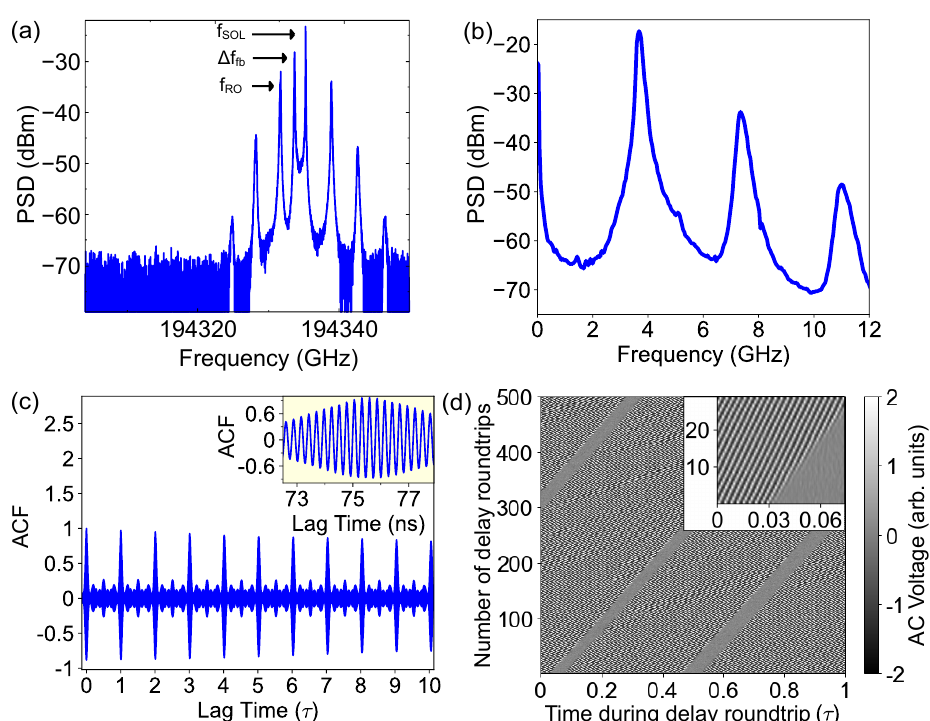
Figure 7. Characteristics for undamped relaxation oscillation dynamics at a bias current of I = 18 mA and a feedback rate that has been attenuated by 31 dB from its maximum value. ( a ) Optical spectrum, ( b ) RF power spectrum, ( c ) Autocorrelation function (ACF) of the intensity time series with inset around the first delay echo, ( d ) Spatio-temporal representation of the intensity time series with inset for magnification of the intensity dynamics around the